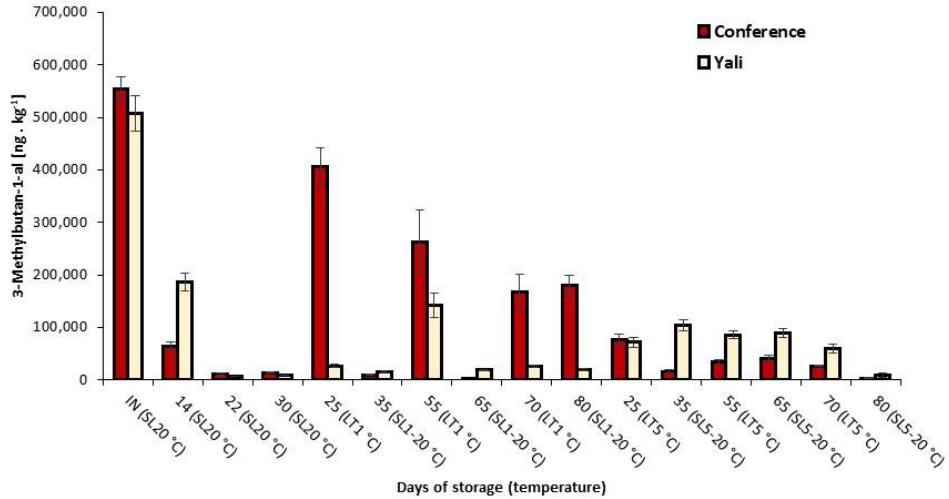
Figure 3. Concentration changes of 3-methylbutan-1-al in ‘Conference’ and ‘Yali’ pear cultivars depending on time and storage regimes. (SL20 °C — shelf-life at 20 °C; LT — low storage at 1 or 5 °C; SL1-20 °C, SL5-20 °C — shelf-life at 20 °C after storage at 1 or 5 °C).